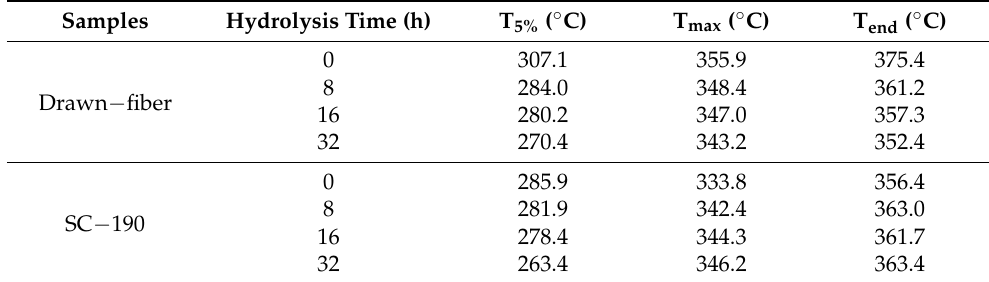
Table 7. Thermal decomposition temperature of drawn − fi ber and SC − 190 fiber hydrolyzed for dif- ferent times.